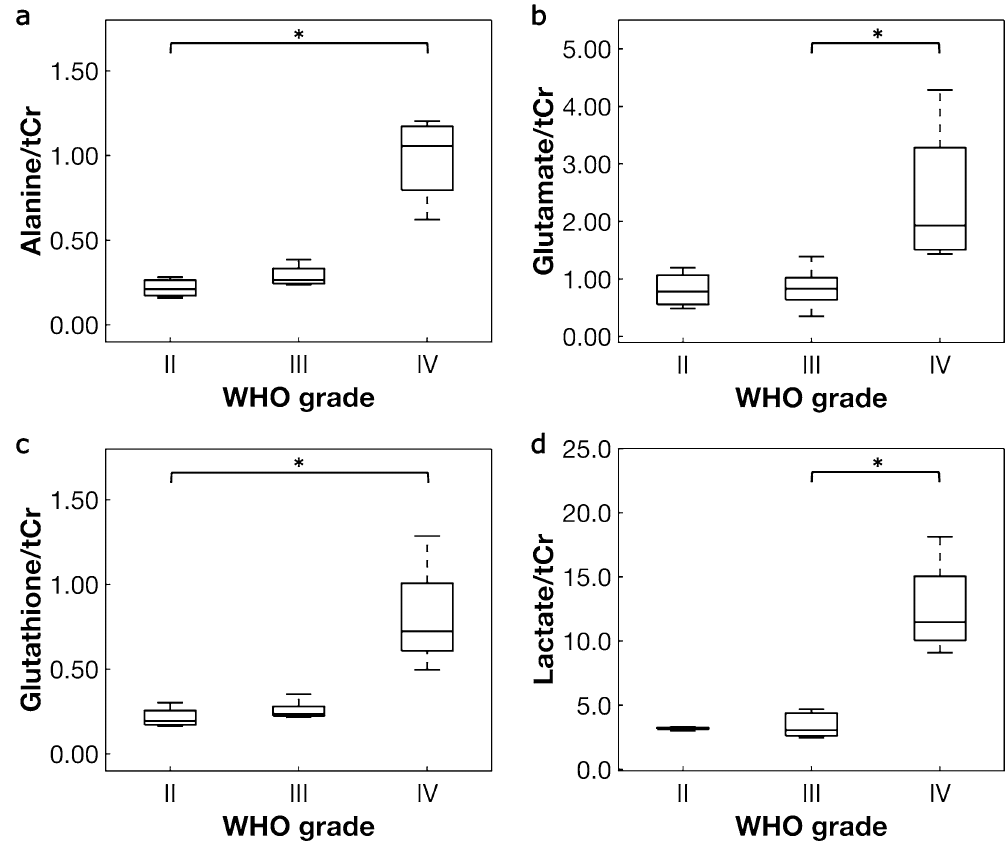
Figure 1. Box plots of tumor metabolites that varied significantly as a function of WHO grade. Metabolites in glioma samples were quantified using 1 H HRMAS NMR. Differences as a function of WHO grade were assessed with Kruskal–Wallis H-tests and post-hoc pair-wise Dunn’s tests (Table 2). A Bonferroni correction was applied to the p value of the Dunn’s test to correct for multiple comparisons within each metabolite. Metabolites that varied significantly in post-hoc analysis include ( a ) alanine, ( b ) glutamate, ( c ) glutathione, and ( d ) lactate. Metabolite concentrations were normalized to creatine + phosphocreatine (tCr). *Denotes significance at p ≤ .05.